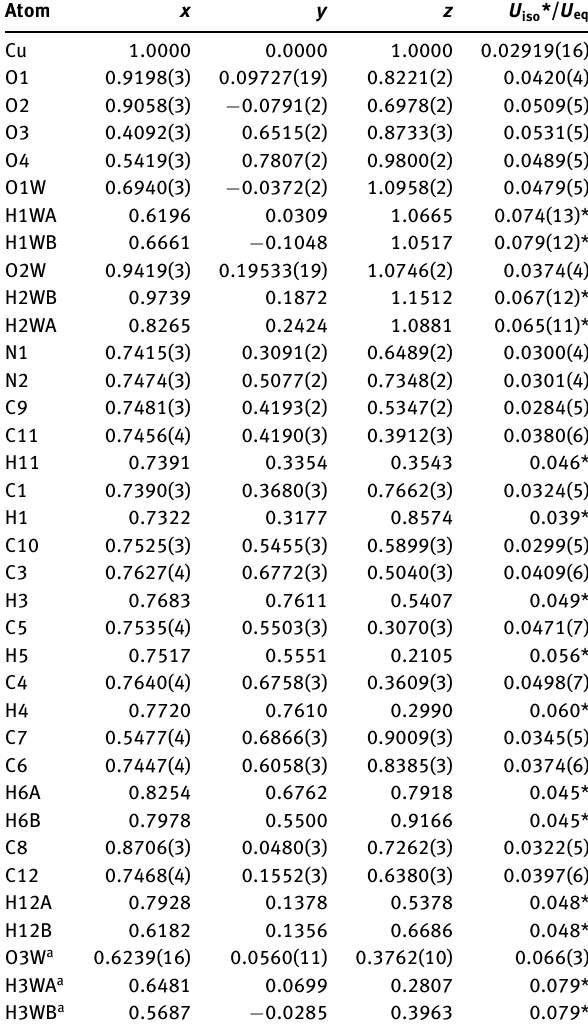
Table 2: Fractional atomic coordinates and isotropic or equivalent isotropic displacement parameters (Å 2